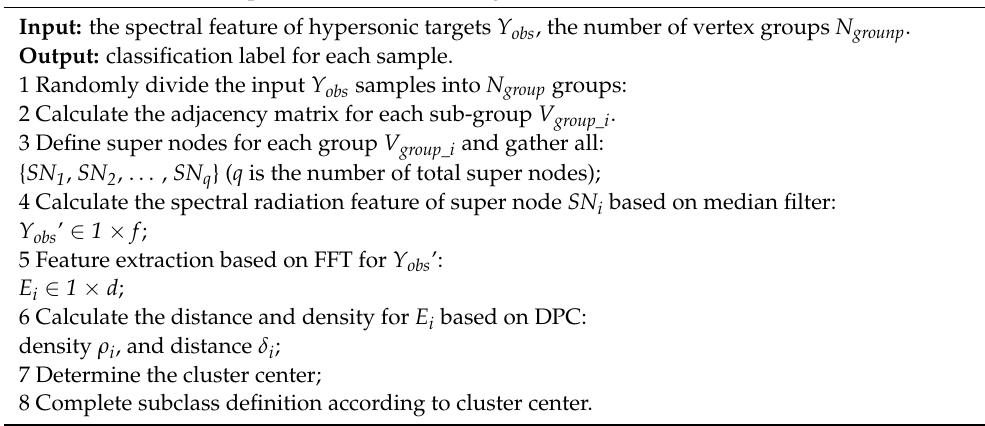
Algorithm 1 . The unsupervised classification